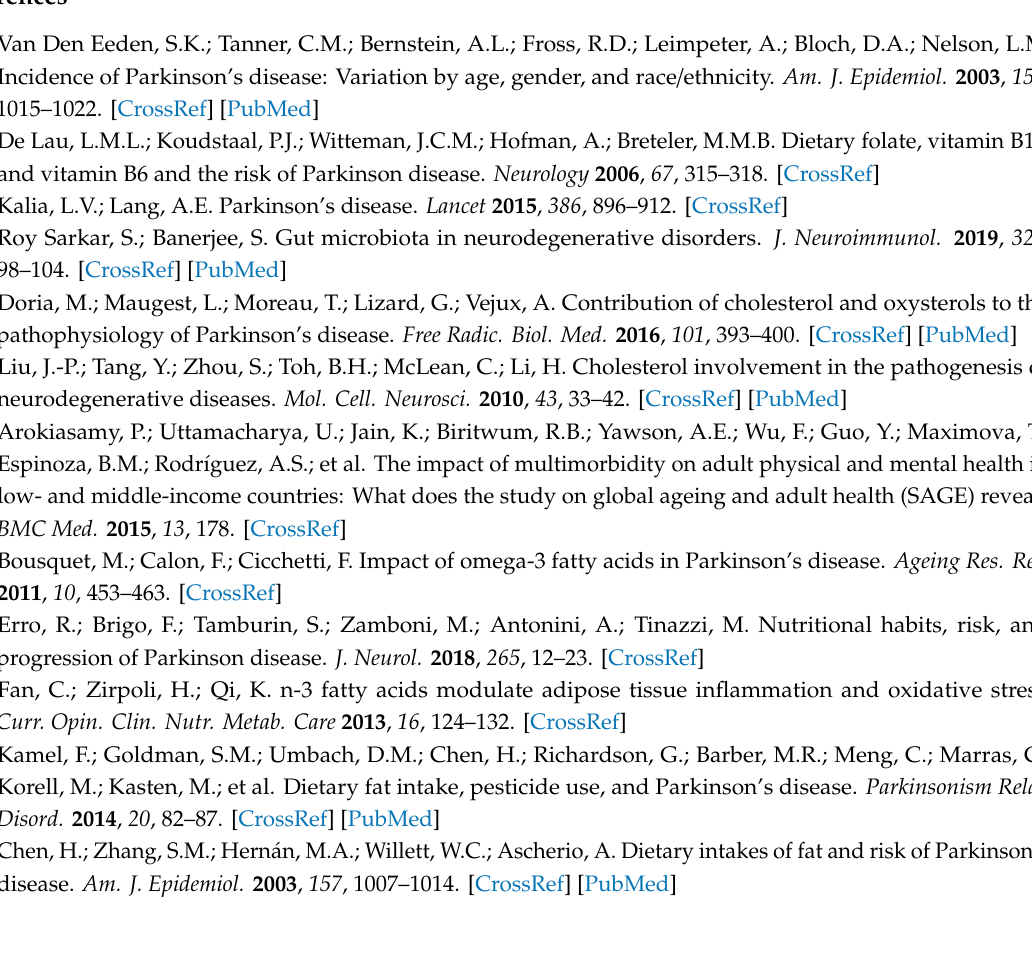
Table S1: Dietary fat intake and PD risk, Table S2: Vitamins intake and PD risk, Table S3: Minerals intake and PD risk, Table S4: Uric Acid level and PD risk, Table S5: Dairy product intake and PD risk, Table S6: Consumption of alcoholic beverages and PD risk, Table S7: Co ff ee, tea and other polyphenols containing food items and PD risk, Table S8: Dietary patterns and PD risk, Table S9: Microbiota and PD